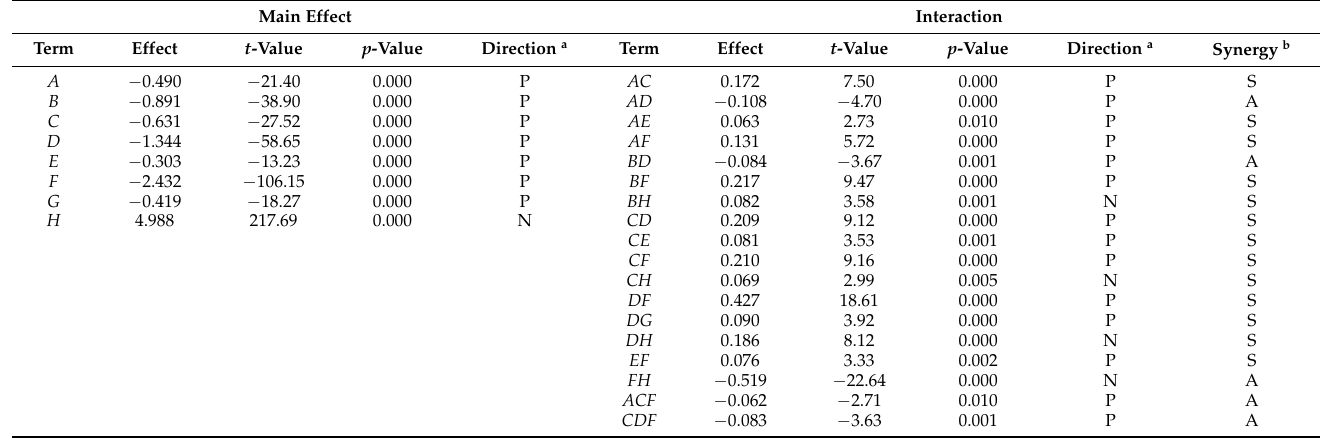
Table A1. The significant main effects and interactions with the total infiltration.